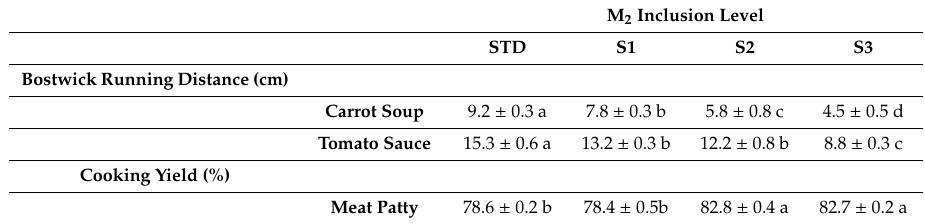
Table 5. Bostwick Running Distance of carrot soup and tomato sauce, and cooking yield of a meat patty at increasing M 2 inclusion level, 1%, 2% and 3%, g of flour / 100 g sample.